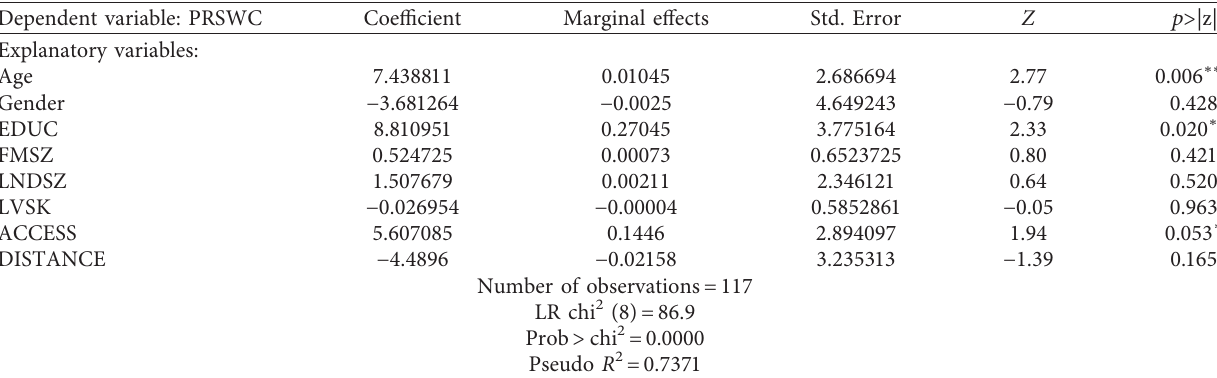
Table 5: Model results for the perception of integrated use of soil bund with desho